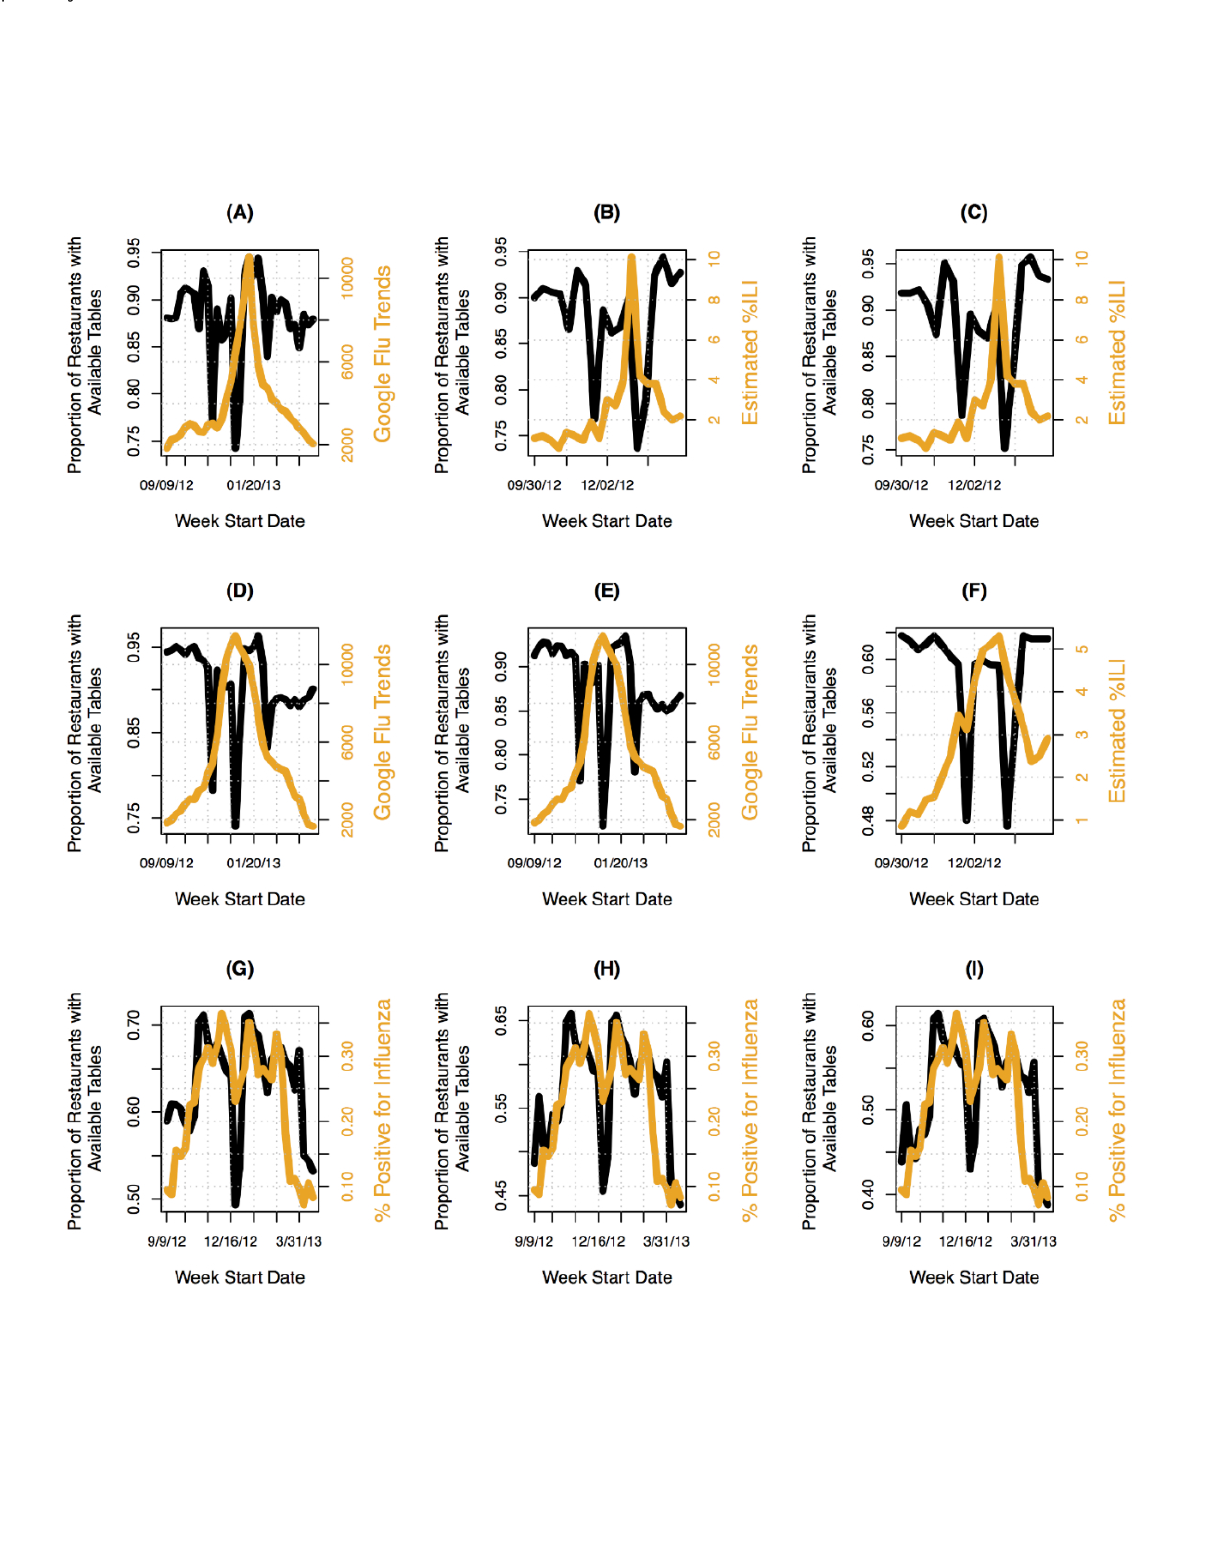
Figure 2. The trend in the proportion of restaurants with table availability compared to trend in various estimates of influenza activity for different regions. (A) Google Flu Trend and restaurant table availability for Baltimore at 7:30 PM; (B, C) estimated % influenza-like illness (ILI) for Maryland and restaurant table availability for Baltimore at 7:00 PM and 3:30 PM, respectively; (D, E) Google Flu Trend and restaurant table availability for Atlanta at 3:00 PM and 6:30 PM, respectively; (F) estimated % ILI for Georgia and restaurant table availability for Atlanta at 12:30 PM; (G-I) Pan American Health Organization (PAHO) % positive for influenza and restaurant table availability for Mexico at 10:00 PM,10:30 PM, and 11:00 PM,